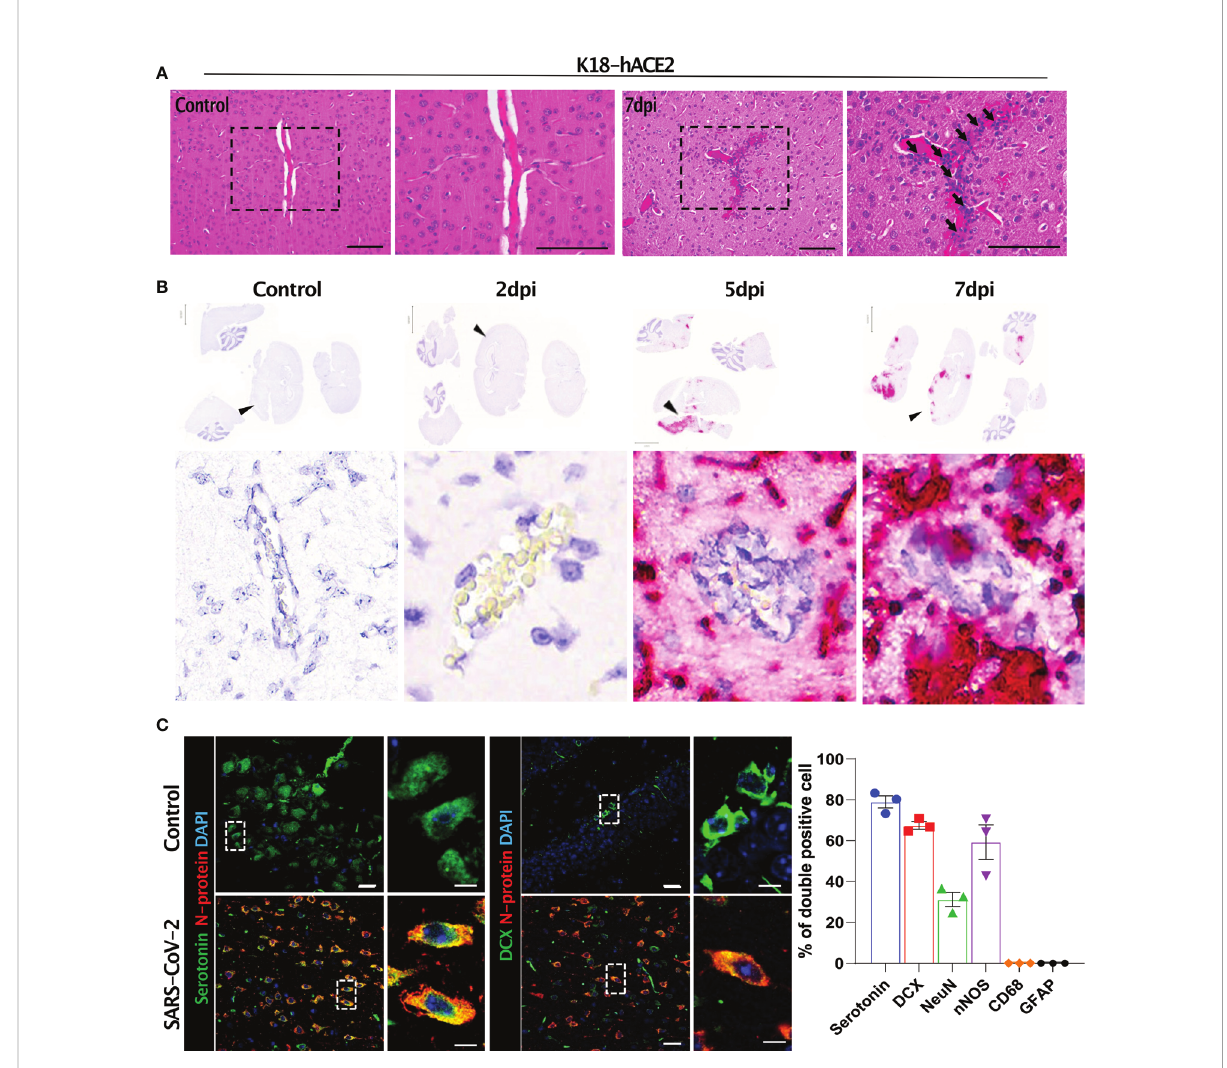
FIGURE 7 Histopathological features of the SARS-CoV-2-infected brain and its target cells in K18-hACE2 mice. (A) H&E-stained brain sections of control and infected mice. Black arrows with tails show perivascular cuf fi ng. (B) In situ hybridisation on the sections in (A) for detecting the SARS-CoV-2 S gene. Black arrowheads indicate perivascular cuf fi ng in S gene-positive infected lesions. (C) Representative images of immuno fl uorescence staining. Sections at 7 dpi were stained with anti-SARS-CoV-2 N protein and either anti-serotonin or anti-DCX antibody and other brain cell markers. Right, summary of the percentage of double-positive cells (SARS-CoV-2 N protein and each brain cell marker). Left panels: green (serotonin), red (N protein), blue (DAPI); right panels: green (DCX), red (N protein), blue (DAPI). Scale bars = 20 m m, 5 m